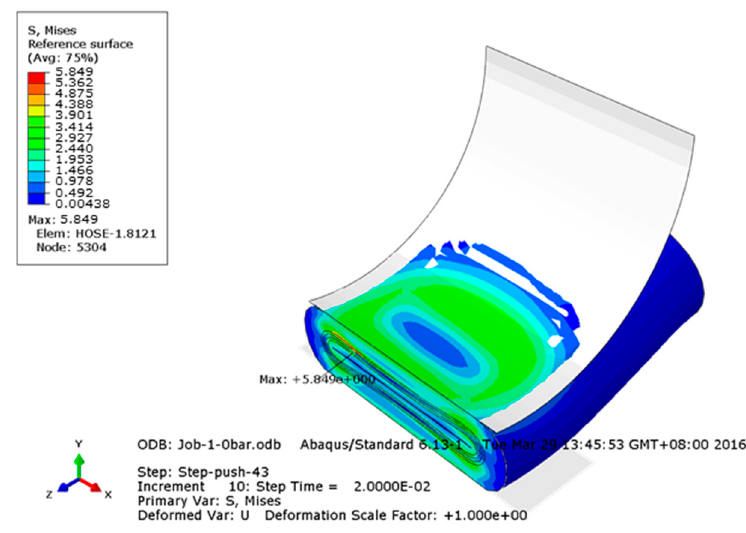
Figure 11. The von Mises stress distribution in the hose.